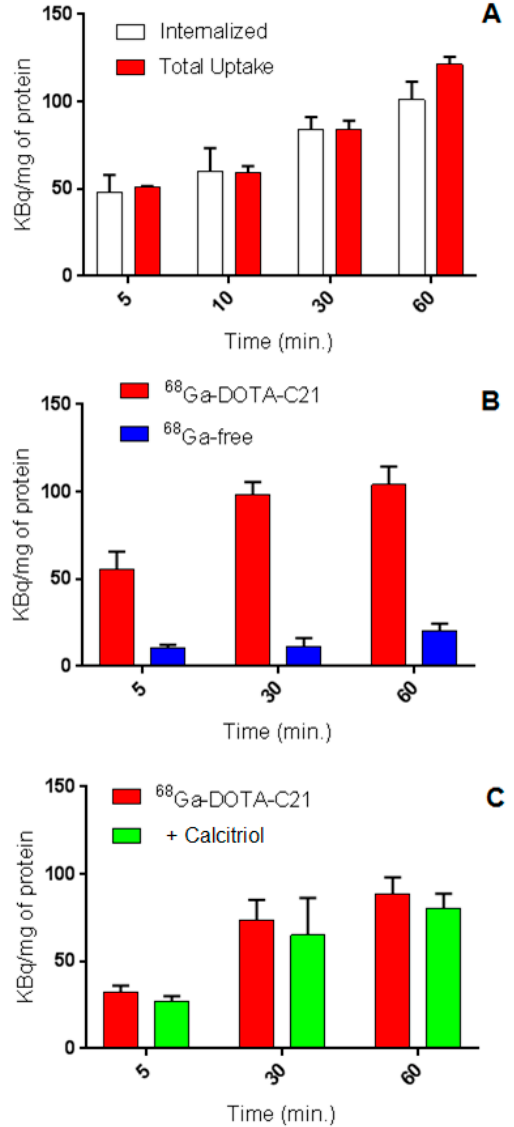
Figure 6. Uptake and internalization at different time points of 68 Ga-DOTA-C21 in HT-29 colorectal cancer cell line ( n = 3, mean ± SD) ( A ). Comparison between the uptake of 68 Ga-DOTA-C21 and 68 GaCl 3 in HT-29 cells indicating curcumin structure dependent accumulation ( n = 3, mean ± SD) ( B ). Comparison between the uptake of 68 Ga-DOTA-C21 and 68 Ga-DOTA-C21 + calcitriol in HT-29 cells ( n = 3, mean ± SD) ( C ).